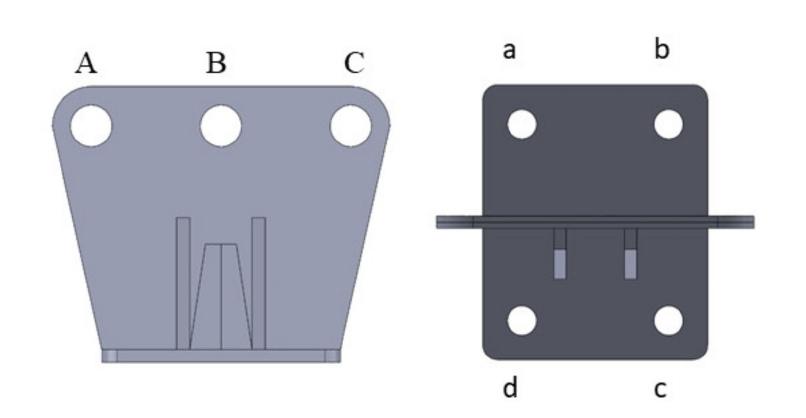
Figure 5. The designations of the bolt holes. A, B, C represent the locations of bolt holes in vertical plate; a, b, c, d represent the location of bolt holes in low bottom plate. Table 2. Extreme conditions list. A,B represent bolt holes A and B are loaded while bolt hole C is unloaded; A,C represent bolt holes A and C are loaded while bolt hole B is unloaded; B,C represent bolt holes B and C are loaded while bolt hole A is unloaded; A,B,C represent bolt A, B, and C are all loaded; a,b,c,d represent bolt hole a, b, c, and d are all fixed; a,b,c represent bolt holes a, b, and c are fixed while bolt hole d is unconstrained; a,b,d represent bolt holes a, b, and d are fixed while bolt hole c is unconstrained; a,c,d represent bolt holes a, c, and d are fixed while bolt hole b is unconstrained; b,c,d represent bolt holes b, c, and d are fixed while bolt hole a is unconstrained. Extreme Condition Sequence